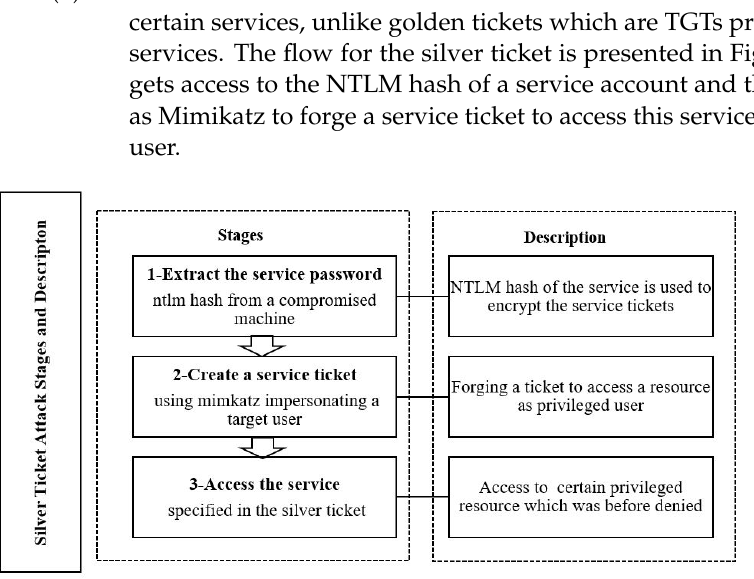
Figure 7. Silver Ticket Attack